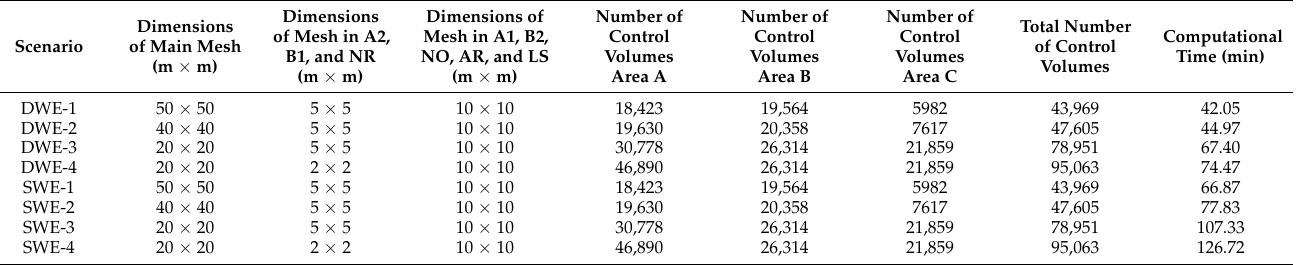
Table 1. Characteristics the eight scenarios.